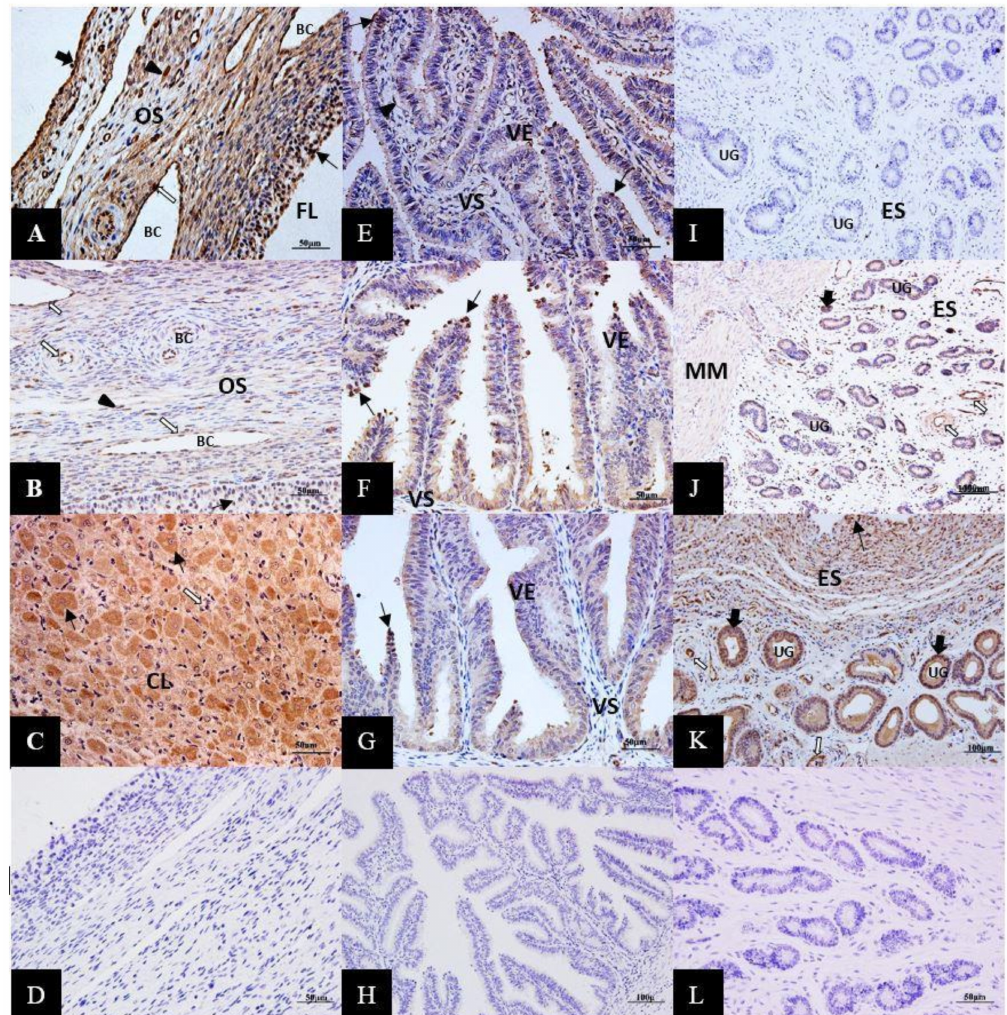
Figure 3. Immunolocalization of ERK1 / 2 proteins (brown stained regions) in the female yak’s ovary ( A , B , C ), oviduct ( E – G ), and uterus ( I , J , K ) during the follicular phase ( A , E , I ), luteal phase ( B , F , J ), and gestation period ( C , G , K ). ( A ) ERK1 / 2 appeared in follicular granulosa cells (thin arrow), ovarian stroma cells (arrowhead), vascular endothelium (thick arrow), and surface epithelium (white thick arrow) of the ovary during the follicular phase. ( B ) ERK1 / 2 proteins moderately expressed in vascular endothelium (thick arrow), vascular endothelium (thick arrow), and follicular granulosa cells (thin arrow) of the ovary during the luteal phase. ( C ) Most of granular luteal cells (thin arrow) were stained into strong brown, while membranous luteal cells (white thick arrow) in corpus luteum of gestation period. ( D ) Negative control, ovary tissue sections were incubated with an equivalent non-immune IgG agent instead of a rabbit polyclonal antibody to ERK1 / 2. ( E , F , G ). The positive reaction of ERK1 / 2 proteins moderately localized in villous epithelial cells (thin arrow) and some dispersed villous stromal cells (arrowhead) of the oviduct. The intensity of ERK1 / 2 proteins expression was slight higher in the luteal phase ( F ) and follicular phase ( E ) compared with that of the gestation period ( F ). ( H ) Negative control of oviduct sections. ( I , J , K ) The main compartments of the ERK1 / 2 protein expression were endometrial epithelium (thin arrow), glandular epithelium (thick arrow), endometrial stroma cells (arrowhead), and vascular endothelium (white thick arrow) of the uterus. The signal intensity of ERK1 / 2 proteins in the uterus of the luteal phase ( J ) and gestation period ( K ) was obviously higher than that of the follicular phase ( I ). ( L ) Negative control of the uterus section. FL: follicle, BC: blood capillary, OS: ovarian stroma, CL: corpus luteum, VE: villous epithelium, VS: villous stroma, UG: uterine gland, ES: endometrial stroma, MM: